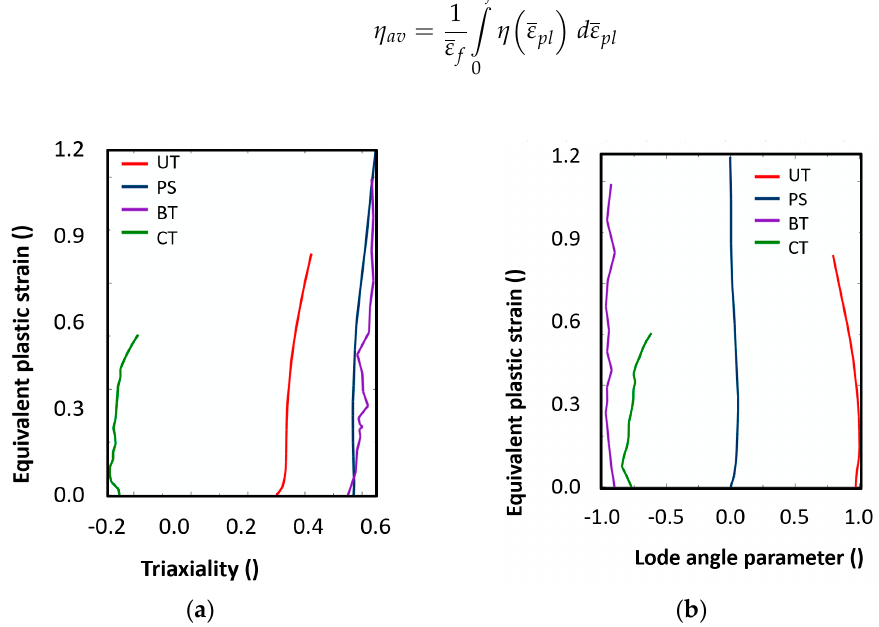
Figure 16. The curves representing dependence of ( a ) strain-triaxiality and ( b ) strain-Lode angle parameter for the samples under uniaxial, plane strain and biaxial tension and uniaxial compression. Lode angle parameter weighted average θ av is expressed in Equation The highest strain values were evaluated as initial fracture strain ε finit. The parame- ters ( ε finit , η , 𝜃 ), which were subsequently used for fracture surface evaluation, are sum-